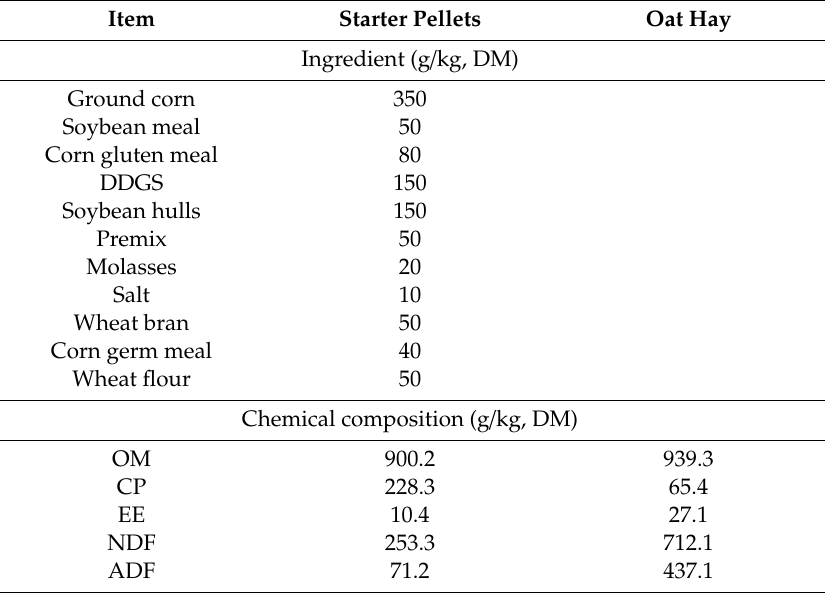
Table 1. Ingredients and chemical composition of experimental diets. Item Starter Pellets Oat Hay Ingredient (g / kg, DM) Ground corn